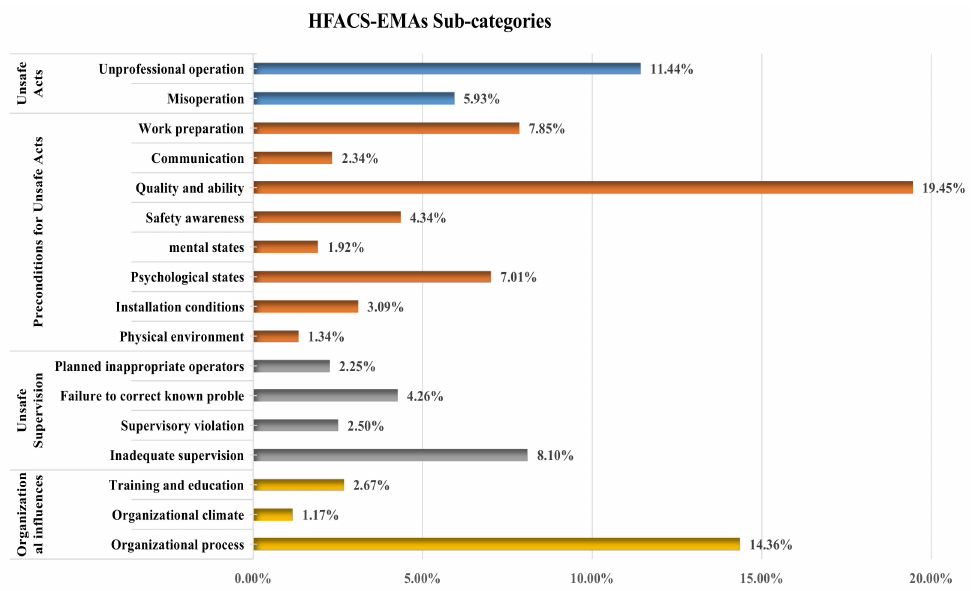
Figure 4. The distribution of HFACS–EMAs